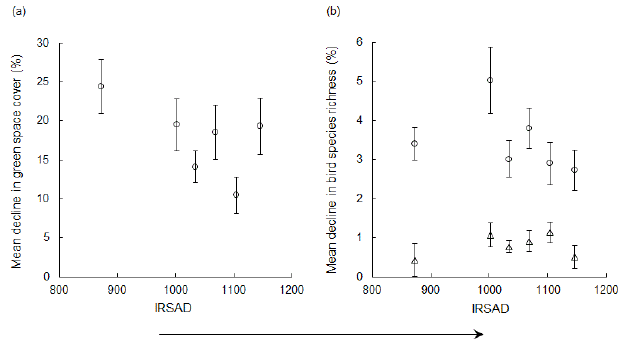
Fig. 5 . The relationship between socioeconomic status, as measured by the Index of Relative Socioeconomic Advantage and Disadvantage (IRSAD) and the proportional decline in (a) total area covered by green space within a 500 meter radius of the home and (b) bird species richness within a 500 meter radius of the home for compact (triangles) and sprawling (circles) urban growth scenarios. There was no change in the amount of green space in the city between the current scenario and the future compact development scenario so no data are shown for the compact development scenario. Data are means ± standard